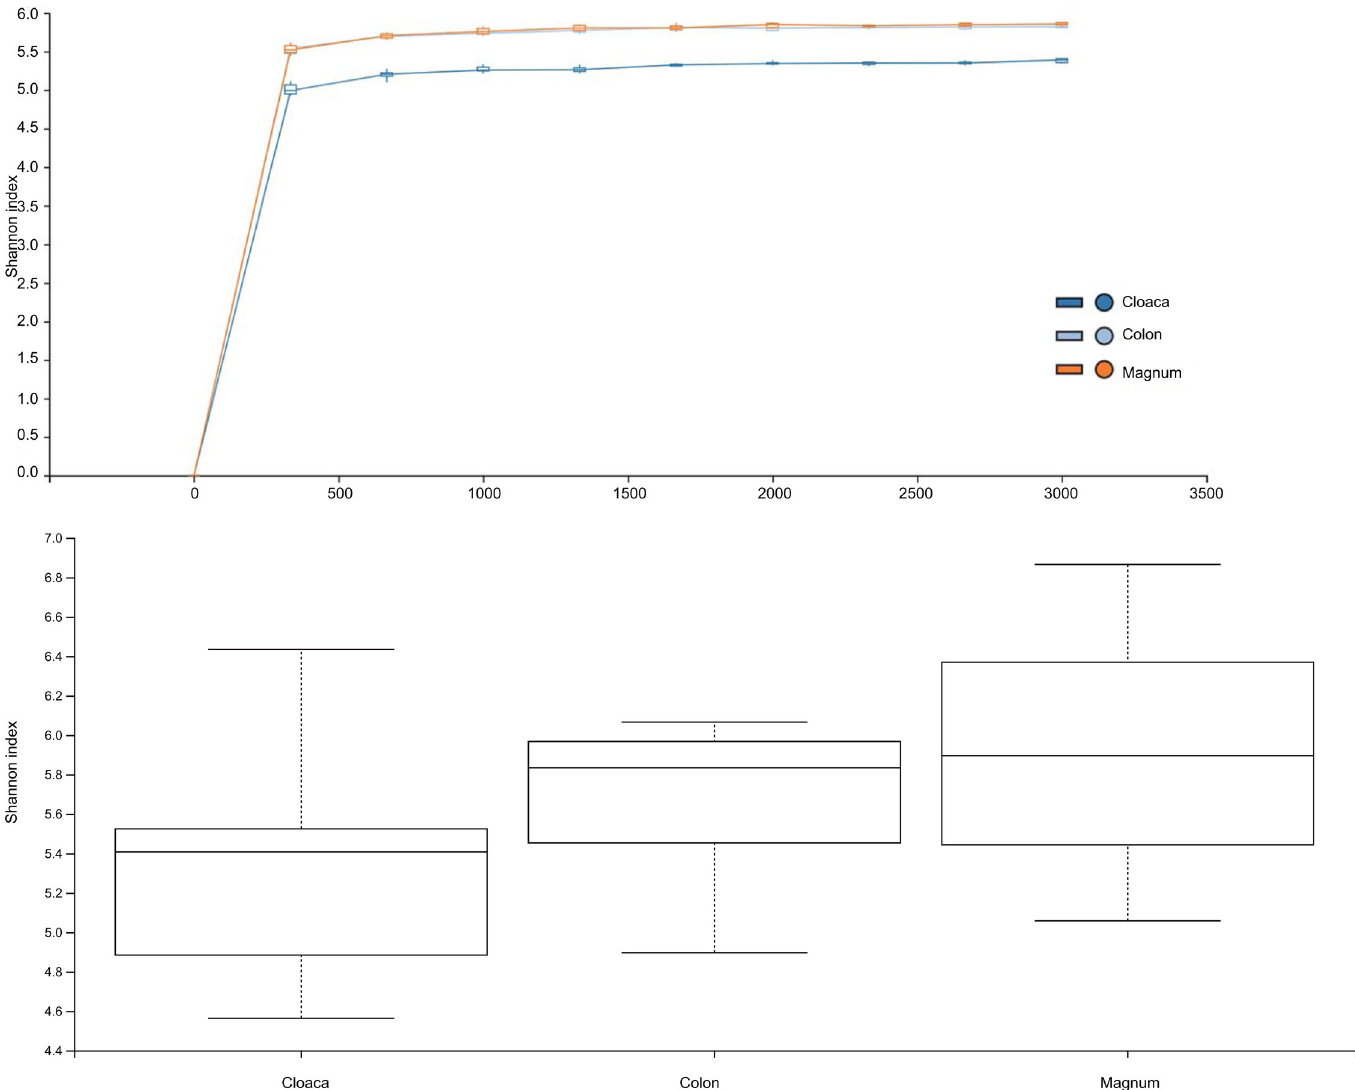
Fig 1. Comparison of the Shannon index between the cloaca, colon, and magnum. Microbiota in the cloaca, colon, and magnum of SPF laying hens were analyzed via Shannon’s index. (A) Rarefaction curve for Shannon’s index. The dark blue line represents the cloaca, the orange line represents the magnum, and the light (sky) blue line represents the colon. (B) Shannon’s index for each group. Box plots show the quartiles, median, and extremities of the values.